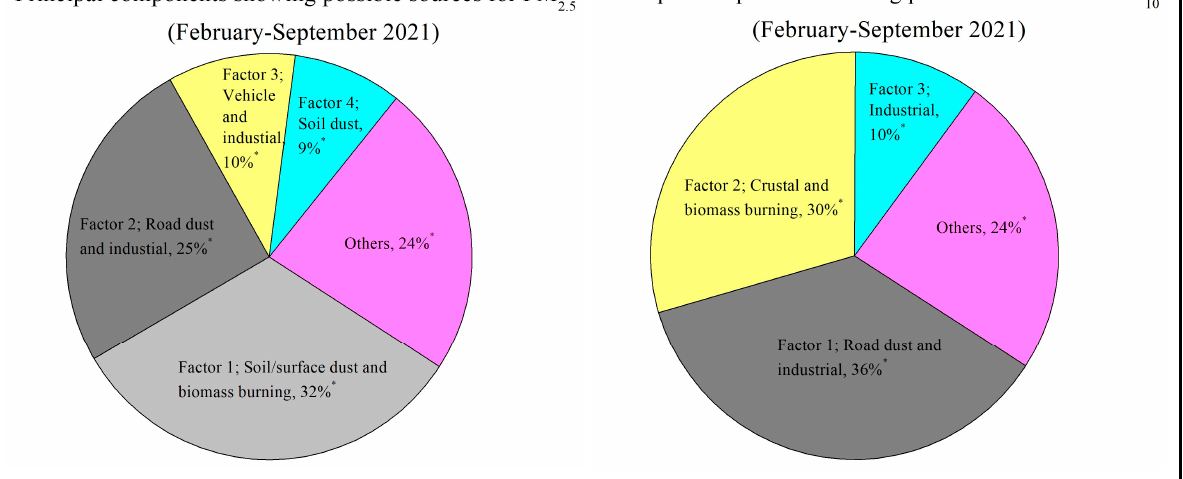
* Percent variance explained Figure 5. Source identi fi cation of PM 2.5 and PM 10 derived from PCA analysis over Pathum Thani Figure 5. Source identification of PM 2.5 and PM 10 derived from PCA analysis over Pathum Thani area during February − September 2021. area during February–September